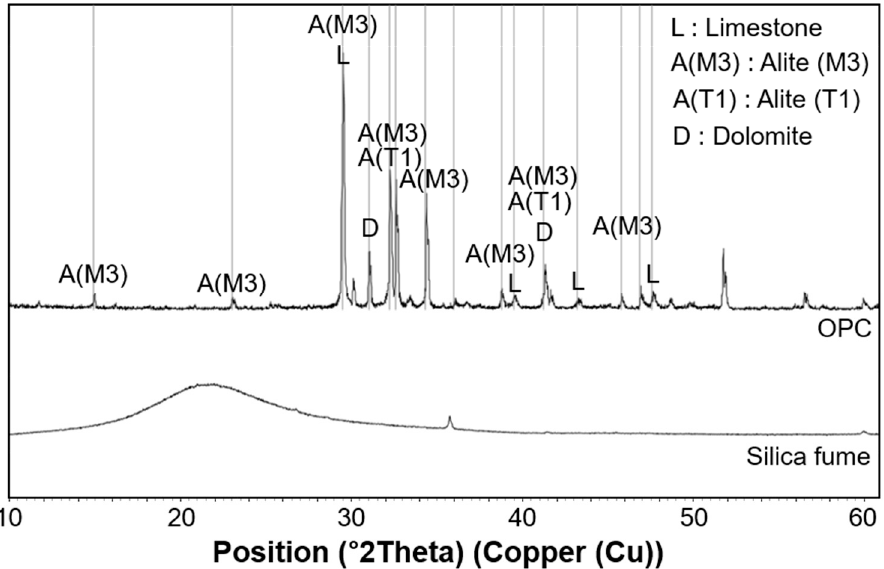
Figure 2. Measured X-ray di ff raction patterns of raw materials.